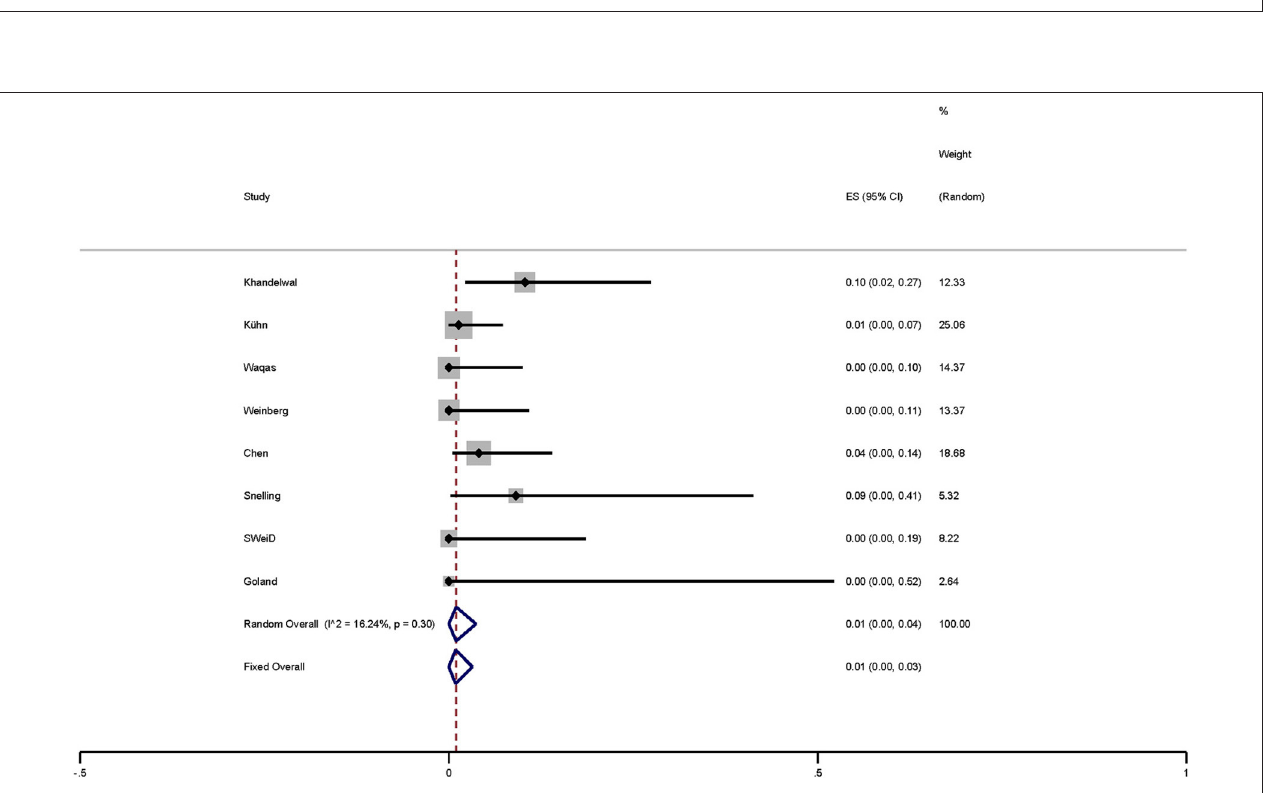
FIGURE 3 | Plot showing the access-related complications of FD-treated intracranial aneurysms via TRA.